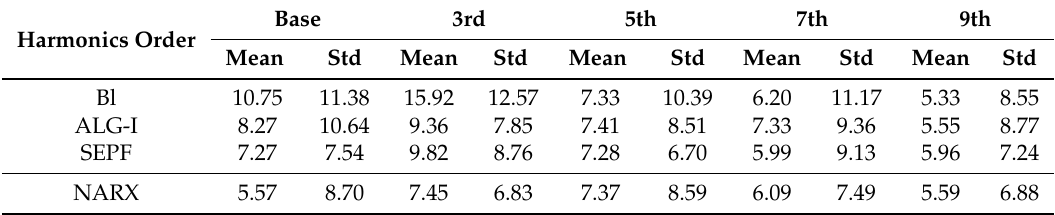
Table 5. Mean square errors of the harmonic identification accuracy (%) with frequency variance.